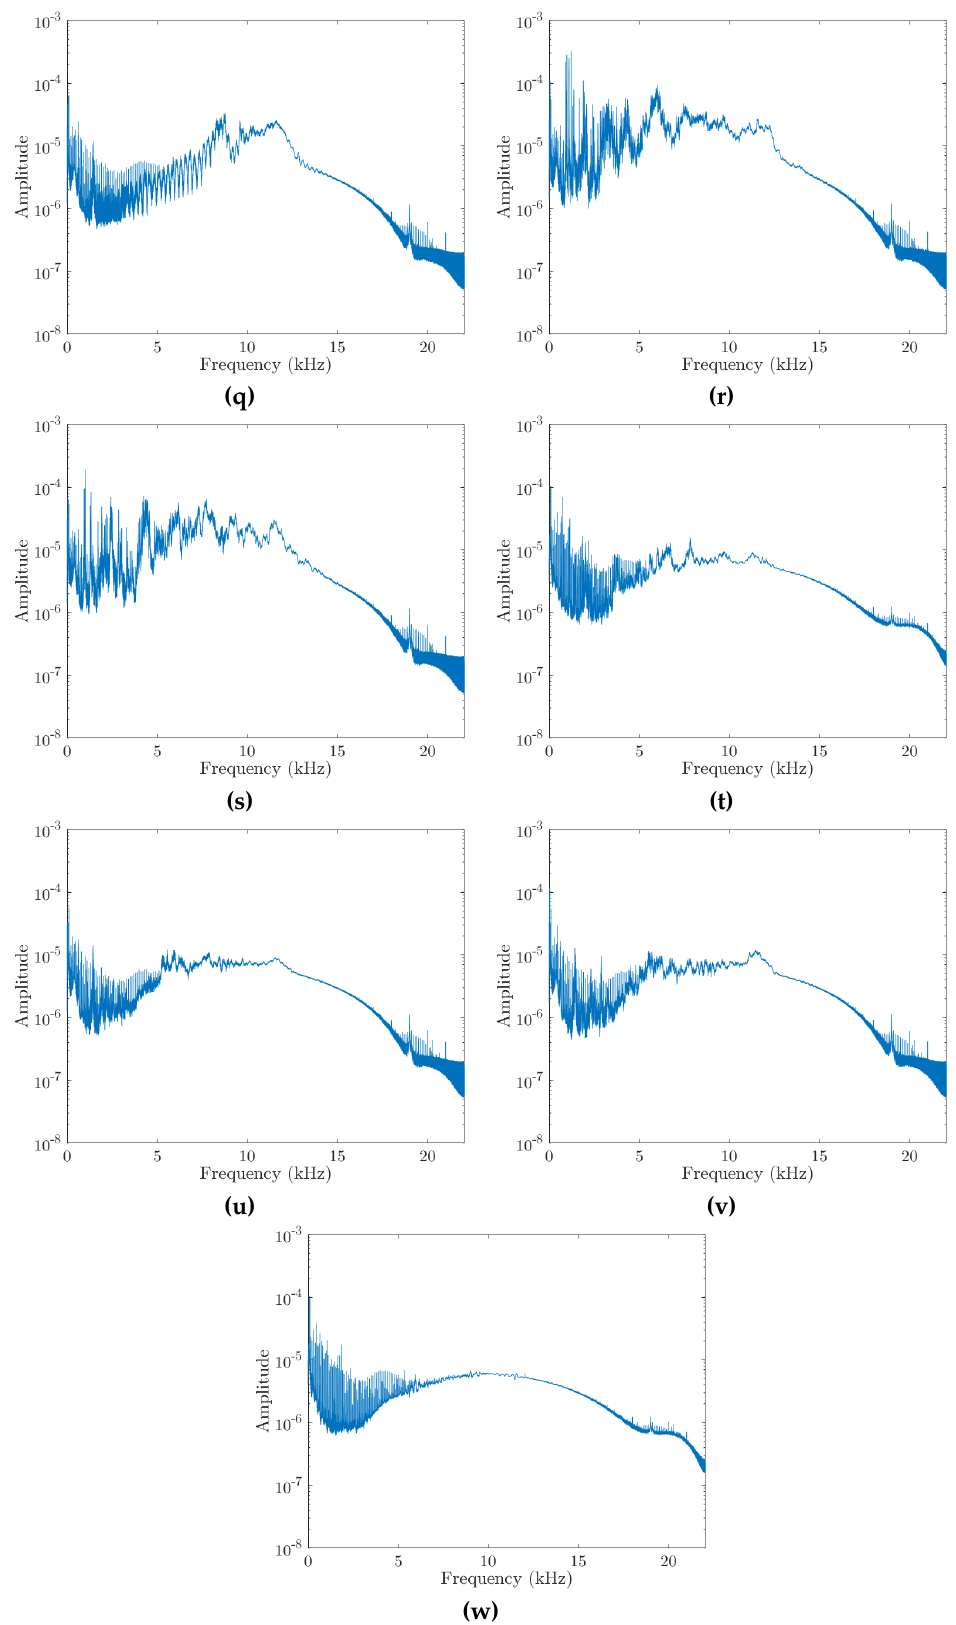
Figure A2. Mean spectra of all 864 Hann windowed responses for each object as measured through the laptop microphone port; as such, the amplitude has no units. Subfigures ( a – w ) corresponding to objects ( a – w ),